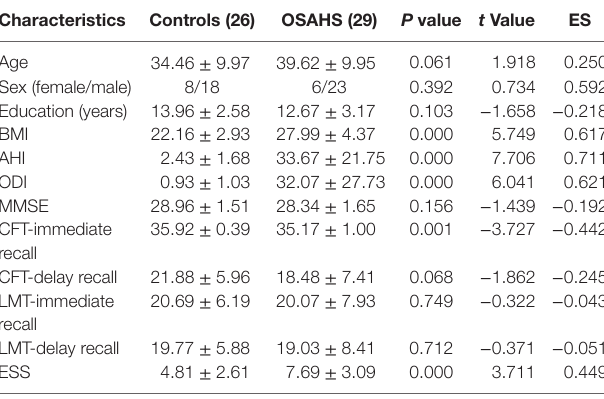
Table 1 | Population statistics and clinical